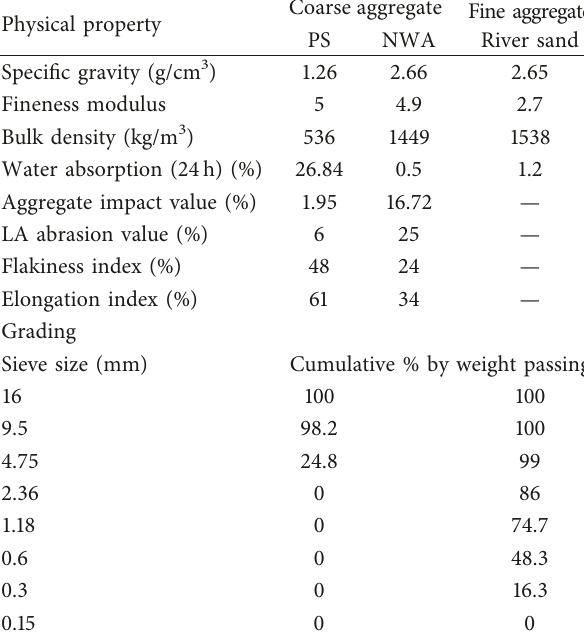
Table 1: Physical properties of the aggregates. Coarse aggregate Physical property